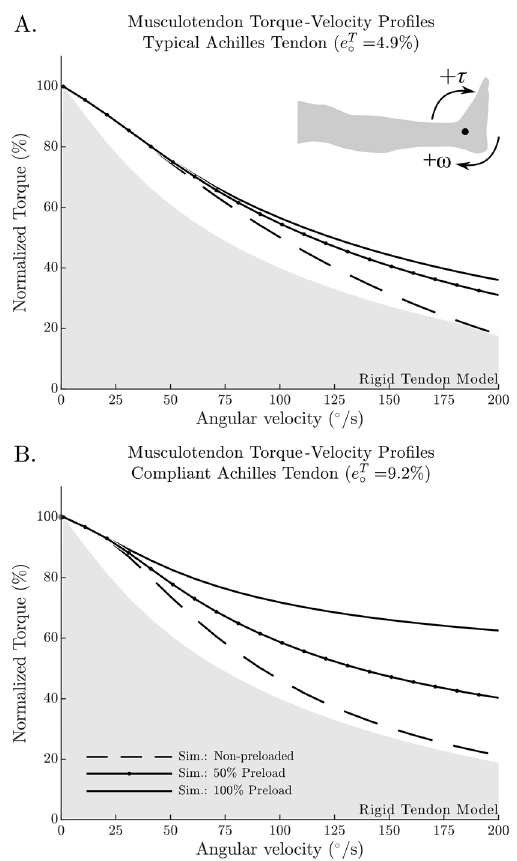
Figure 4. The amount of preload on the Achilles tendon has a nonlinear effect on the resulting T–ω–r during shortening. For example, when shortening is simulated using a 50% preloaded tendon, the resulting T–ω–r profile is not equal to the geometric mean of the non-preloaded and 100% preloaded T–ω–r profiles ( A ). The compliance of the tendon directly affects the relative position of the 50% preloaded simulation: when a typical Achilles tendon is used, the 50% preloaded T–ω–r is closer to the 100% preloaded T–ω–r ( A ); in contrast, when a compliant Achilles tendon is used ( B ), the 50% preloaded T–ω–r is closer to the non-preloaded T–ω–r. As a reference, the output of the rigid tendon model is illustrated as the filled grey area ( A and B